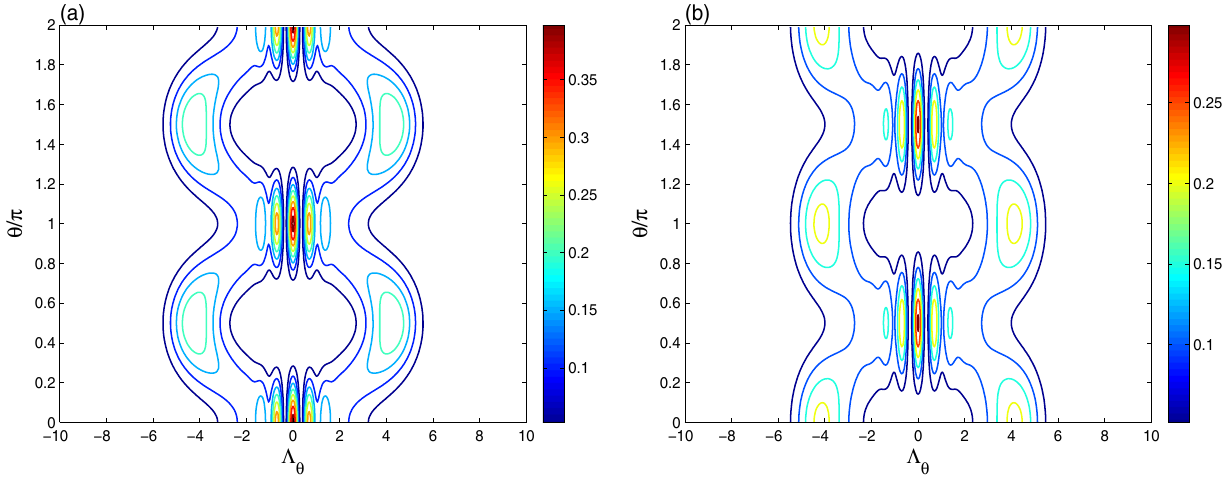
Figure 5. The effect of the intrinsic decoherence on the optical tomography dynamics of the Fig. 2b,c for γ = 0.05 (cid:31)